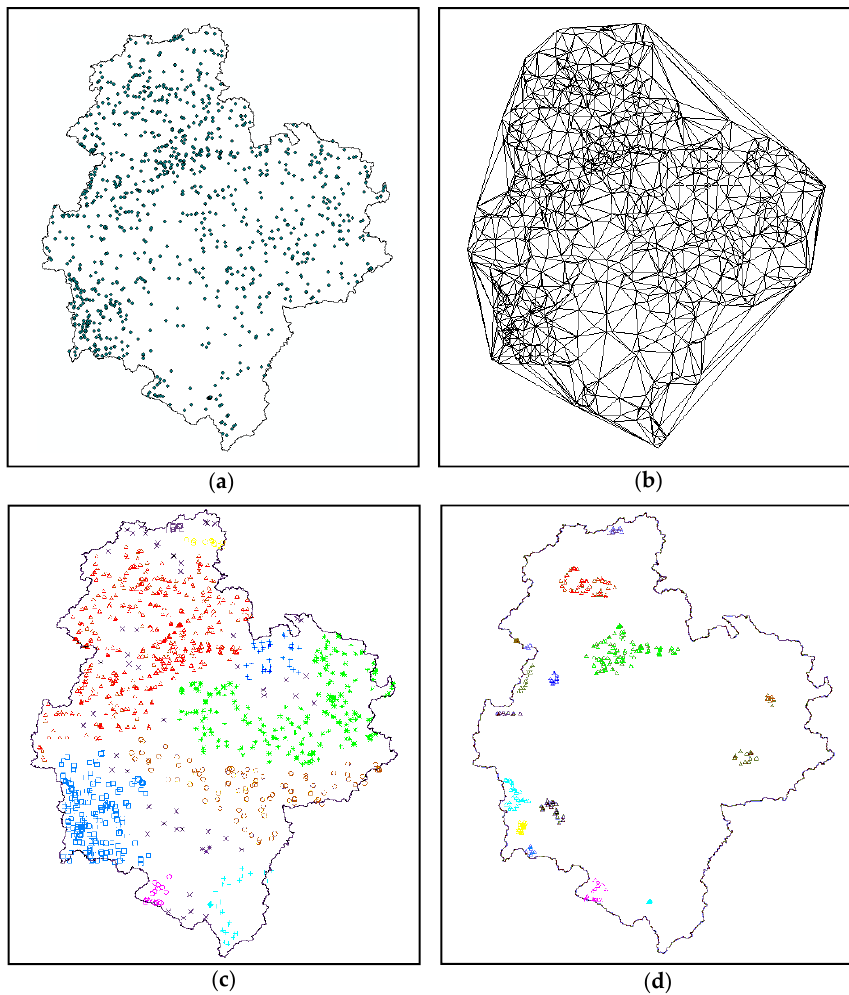
Figure 16. Spatial clustering results for disaster database by ASC: ( a ) Distribution of disaster data points; ( b ) description of spatial neighborhood relations via Delaunay triangulation; ( c ) clustering result of ASC; and ( d ) clustering result of user-defined threshold setting ( ε = 1000